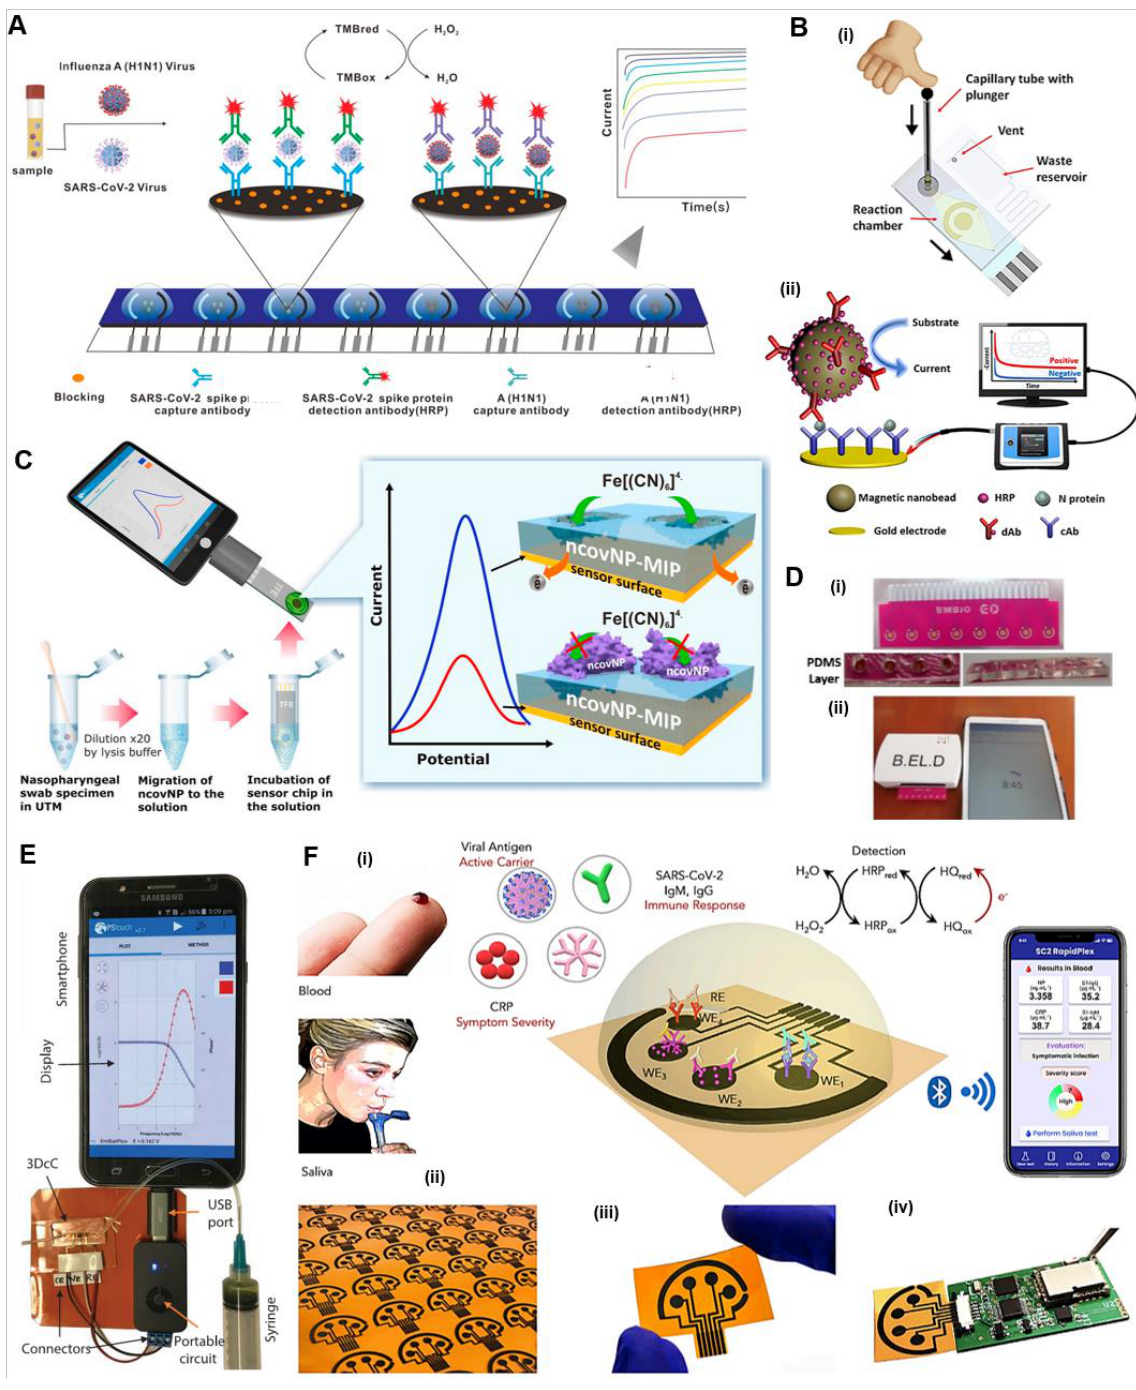
Figure 4. Chip-based potential electrochemical immunoassays—Part 2. ( A ) Schematic outline of the multichannel electrochemical immunoassay (MEIA) for antigen detection of SARS-CoV-2 and influenza A(H1N1) virus. Adapted with permission from [110]. Copyright 2021, American Chemical Society under ACS COVID-19 subset for unrestricted RESEARCH reuse. ( B ) Schematic drawing of the microfluidic magneto immunosensor chip and dually labeled magnetic enrichment for COVID- 19 diagnosis using the smartphone-assisted potentiostat (i) and desktop PC-connected PalmSens4 analyzer. Reproduced with permission from [111]. Copyright 2021, American Chemical Society under ACS COVID-19 subset for unrestricted RESEARCH reuse. ( C ) Illustrated scheme of molecularly imprinted polymer (MIP)-based and smartphone-integrated disposable electrochemical biosensor for SARS-CoV-2 N protein detection. Adapted with permission from [92]. Copyright 2021, Elsevier B.V. ( D ) Vero/anti-S1 cell-based electrochemical biosensor platform for bioelectric recognition assay